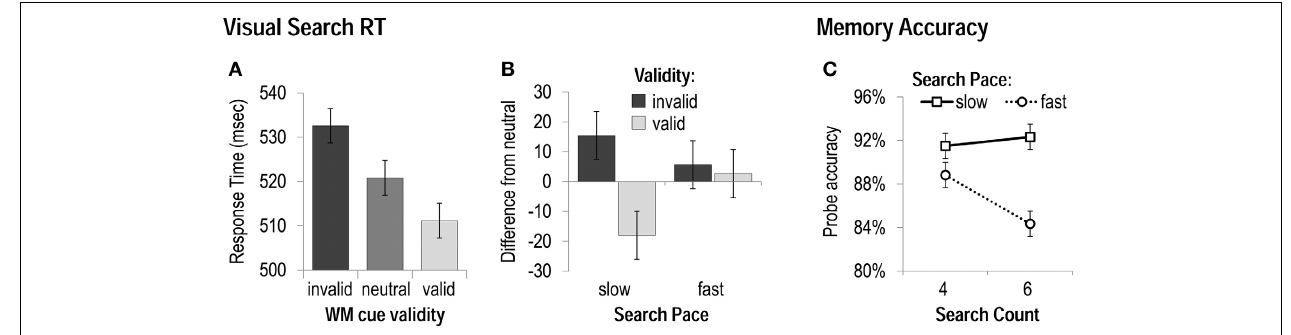
FIGURE 3 | Task performance in Experiment 2. (A) Response Times—collapsed across all mini-block conditions—when WM cues were matching visual search distracters (invalid), targets (valid), or did not reappear in the search display (neutral). (B) The magnitude